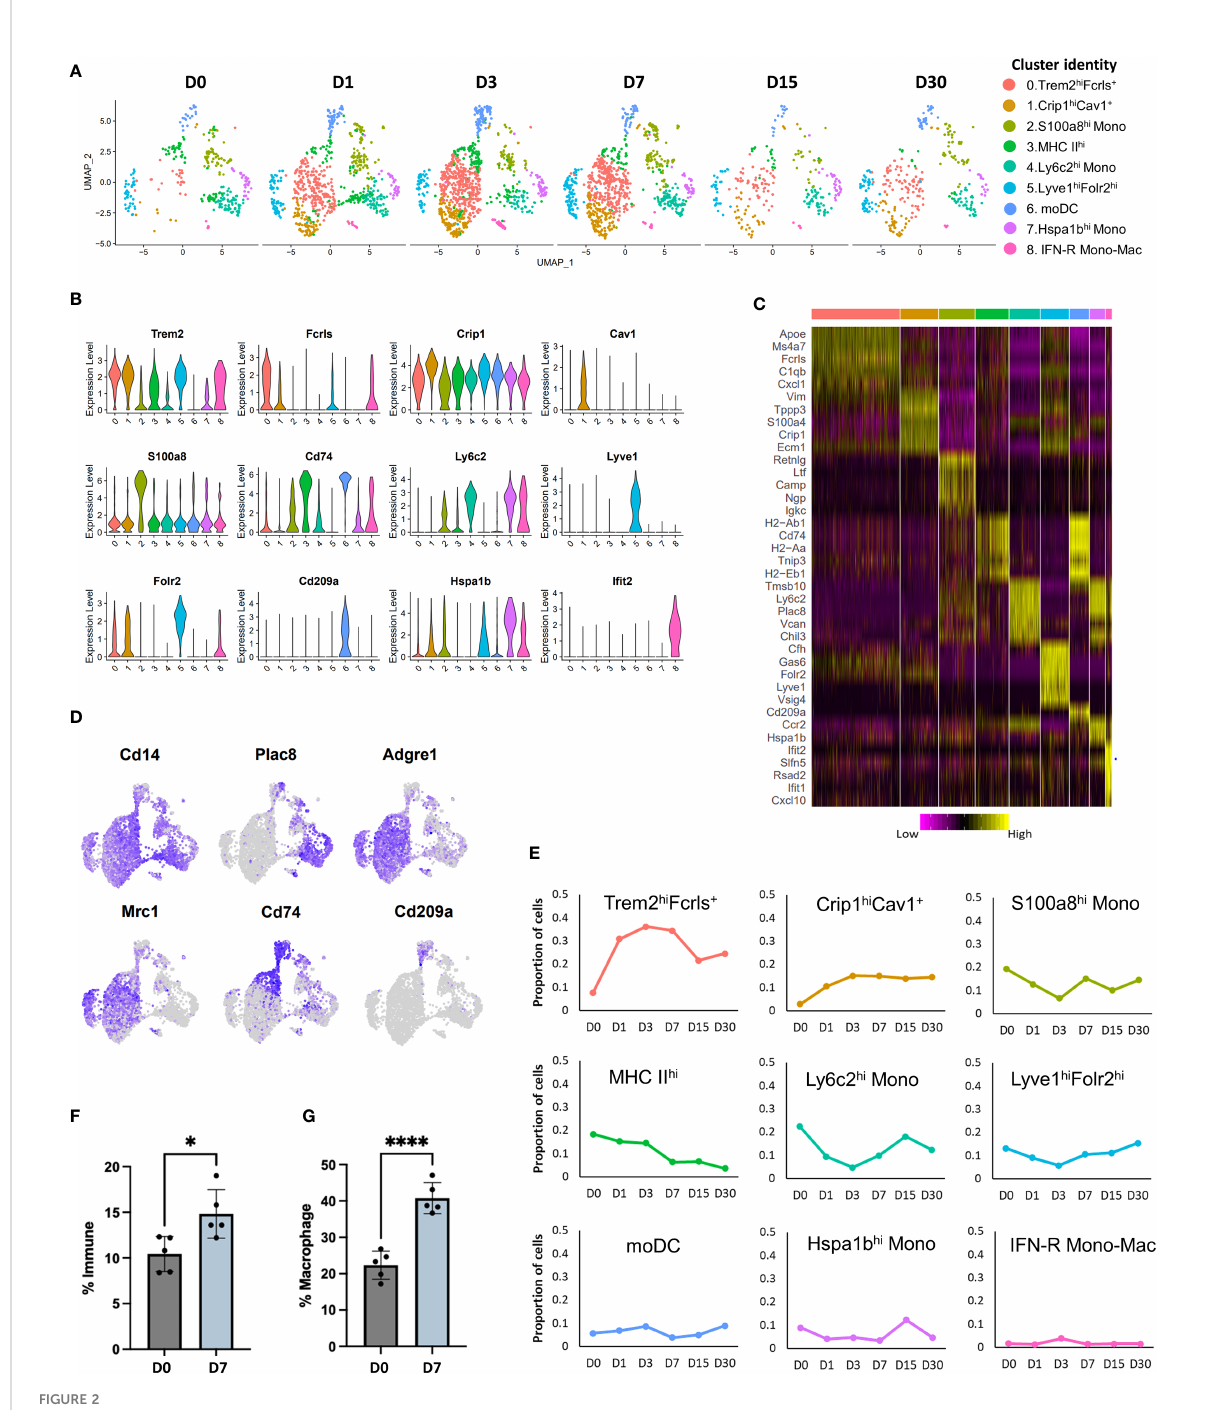
FIGURE 2 Characterization of injury-induced changes in monocyte/macrophage populations. (A) UMAP plots of nine monocyte and macrophage subtypes identi fi ed in mouse knee joints at various timepoints. (B) Violin plots showing the expression of selected markers of various monocyte and macrophage sub-populations (colored based on cluster identities in panel (A) . (C) Heatmap showing the scaled expression of top genes enriched in each monocyte/macrophage cluster. (D) Feature plots showing the expression of key monocyte and macrophage markers in various clusters. (E) Changes in the proportion of various monocyte and macrophage populations after injury, determined using scRNA-seq (colored based on cluster identities in panel (A) . (F) Flow cytometry analysis of macrophages (CD45 + CD11b + F4/80 + ) in uninjured (D0) and injured (D7) joints. Injured joints at D7 had signi fi cantly more macrophages than D0. Data is represented as mean ± SD. *p ≤ 0.05 (two-sided unpaired t- test). (G) Flow cytometry data showing the proportion of M2-like (CD45 + CD11b + F4/80 + CD206 + ) macrophages at D0 and D7, relative to all macrophages. D7 joints showed a signi fi cantly higher proportion of M2-like macrophages compared to D0 joints. Data is represented as mean ± SD. ****p ≤ 0.0001 (two-sided unpaired